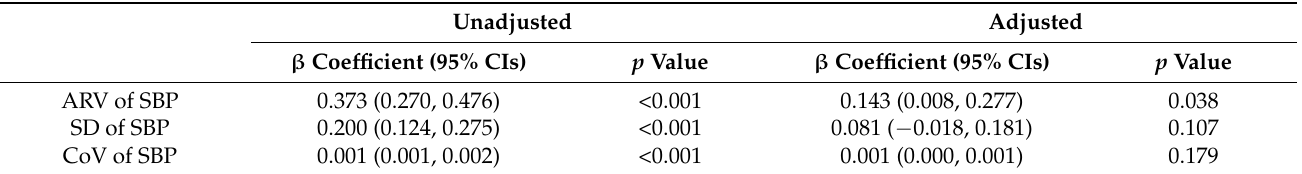
Table 3. Multivariate linear regression analyses of serum OPG level (per pmol/L) for SBPV excluding the subjects with CKD stage